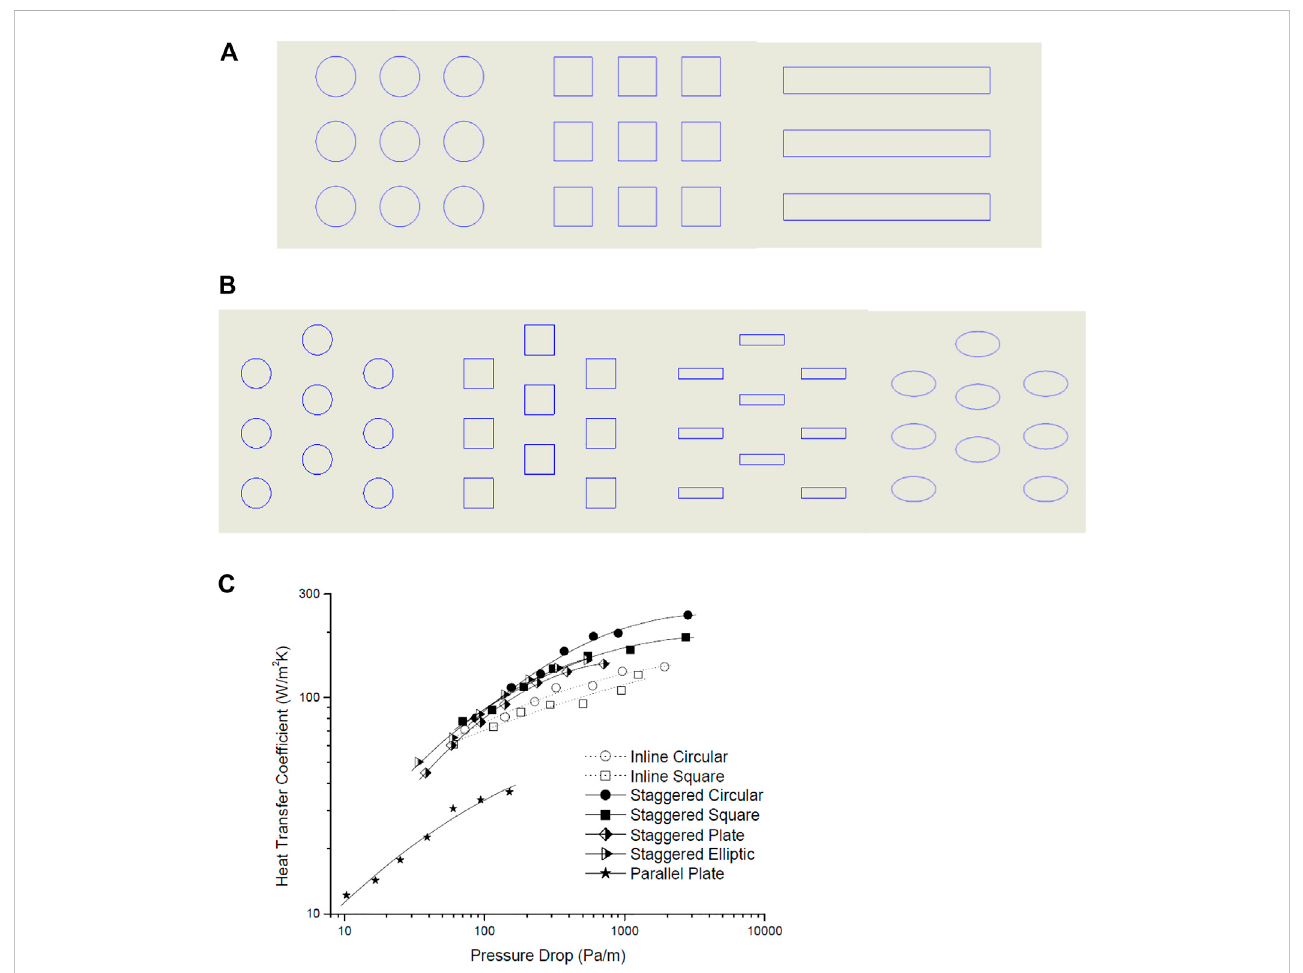
FIGURE 5 (A) i Inline Circular; ii. Inline Square Geometries; iii. Parallel Plates (Mokhtari et al., 2017). (B) I. Staggered Circular; ii. Staggered Square; iii. Staggered Plate iv. Staggered Elliptical (Soodphakdee et al., 2001). (C) Variation of pressure drop versus heat transfer coef fi cient (Soodphakdee et al.,